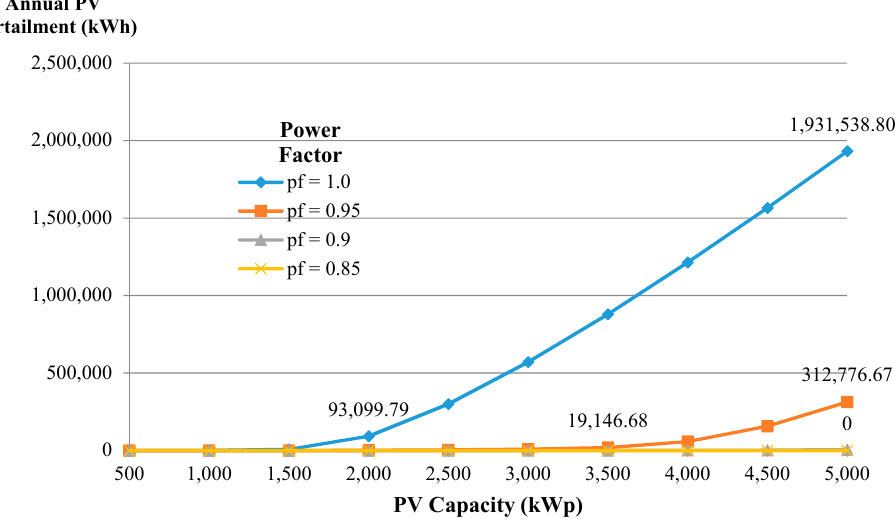
Figure 8. Annual PV real power curtailment for control abilities pf = 1.0, 0.95, 0.9, and 0.85.